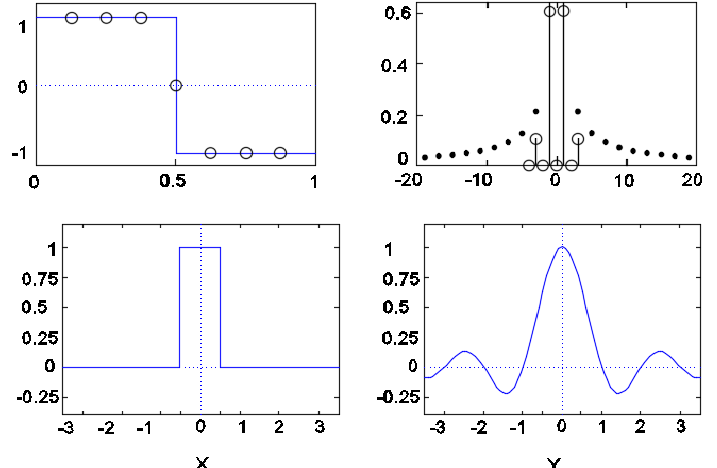
Figure 2. Conversion of a continuous signal to discrete and newly continuous through the Fourier transforms, as shown in [16]. Reproduced with permission from John Wiley and Sons,